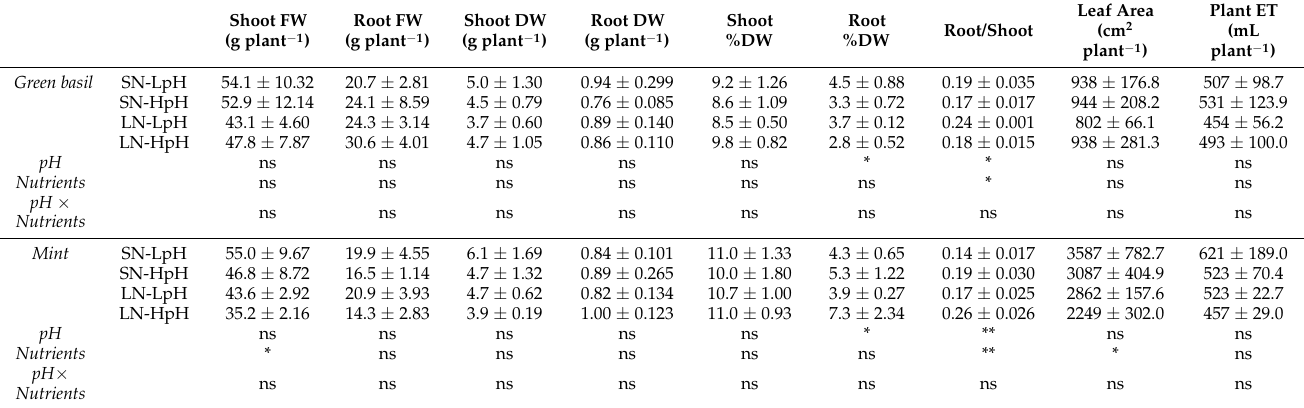
Table 2. Growth parameters of green basil, mint, red basil, and rocket